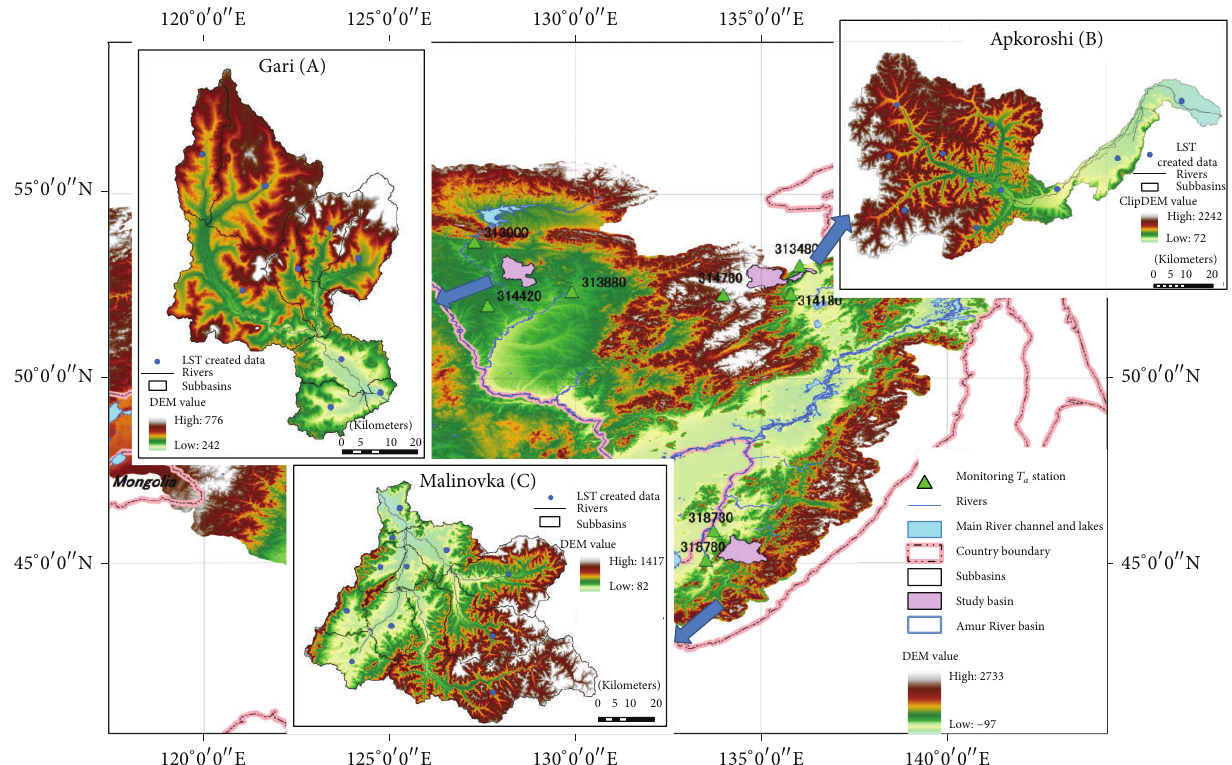
Figure 1: Study area and location of three test basins: Gari (A), Apkoroshi (B), and Malinovka (C).